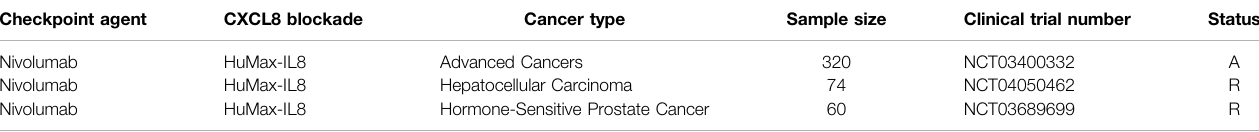
TABLE 2 | Clinical Studies of combination of ICI agents and CXCL8 blockade. A = active; R = recruiting. Checkpoint agent